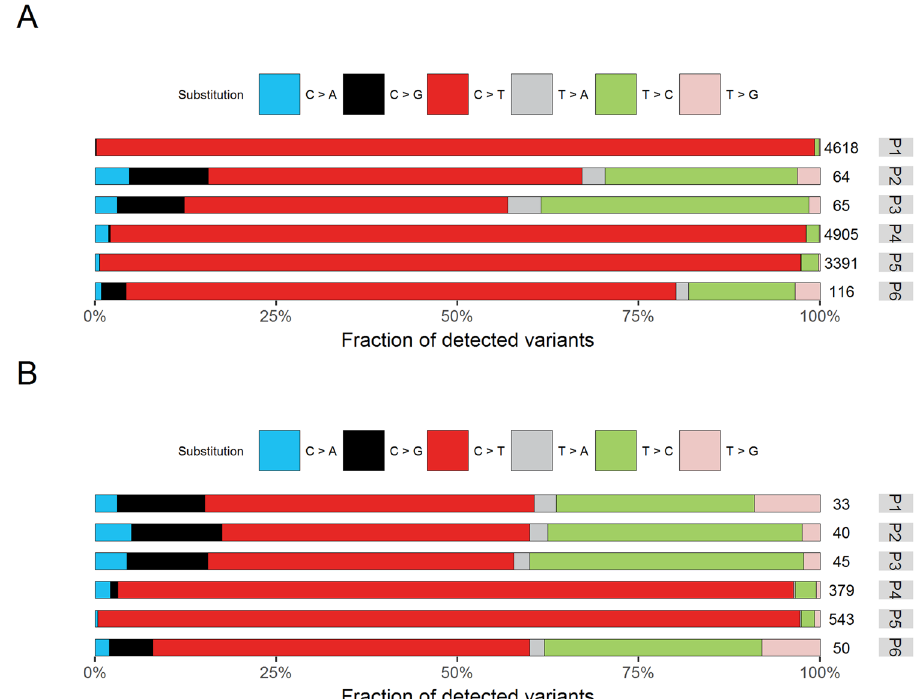
Figure 1. Substitution spectra of variants called relative to the reference genome in DNA derived from formalin fixed paraffin embedded (FFPE) matched normal specimens. ( A ) The contribution of the six possible base substitutions (C > A in blue, C > G in black, C > T in red, T > A in grey, T > C in green and T > G in pink) are depicted for each of six patients (P1 to P6) relative to the total variants in that sample. The total number of detected variants is depicted at the right end of the bars. ( B ) A threshold removing variants with variant frequencies below 35% was applied to FFPE preserved matched normal specimens. The resulting substitution spectra (as in A ) are depicted for each of the six patients (P1 to